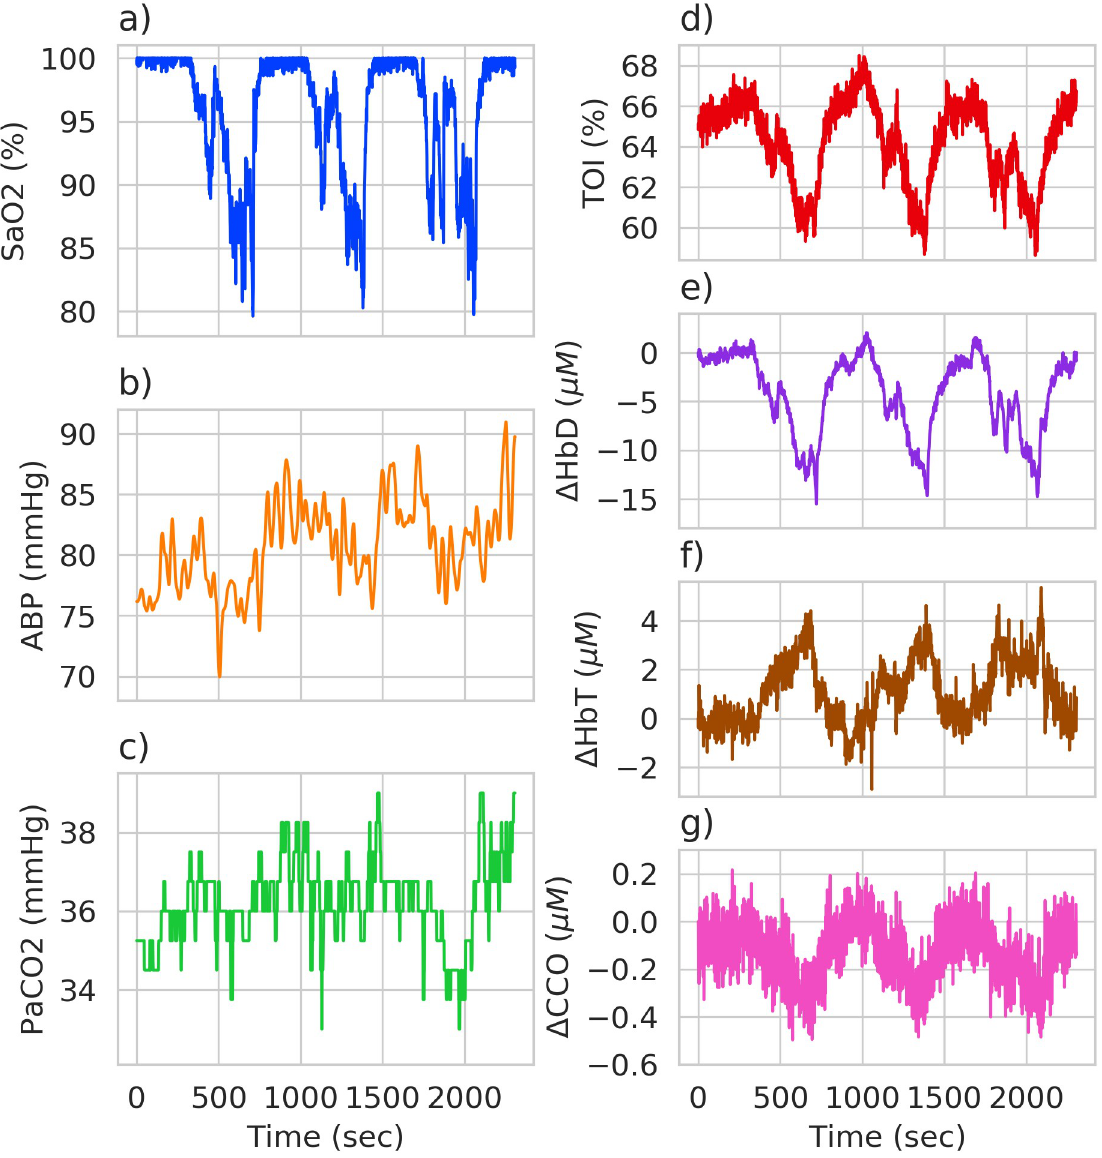
Fig 5. Experimental hypoxia data. Data collected from a healthy adult during a hypoxia challenge. Systemic data used as model inputs are shown in figures a), b) and c), with broadband NIRS measurements shown in figures d), e), f) and